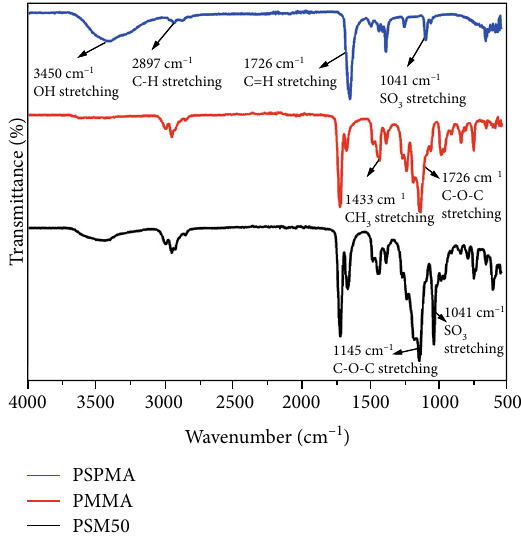
Figure 4: UV-Visible spectra of the synthesized copolymers of poly- 3-sulfopropyl methacrylate and methyl methacrylate, P(SPMA-co-